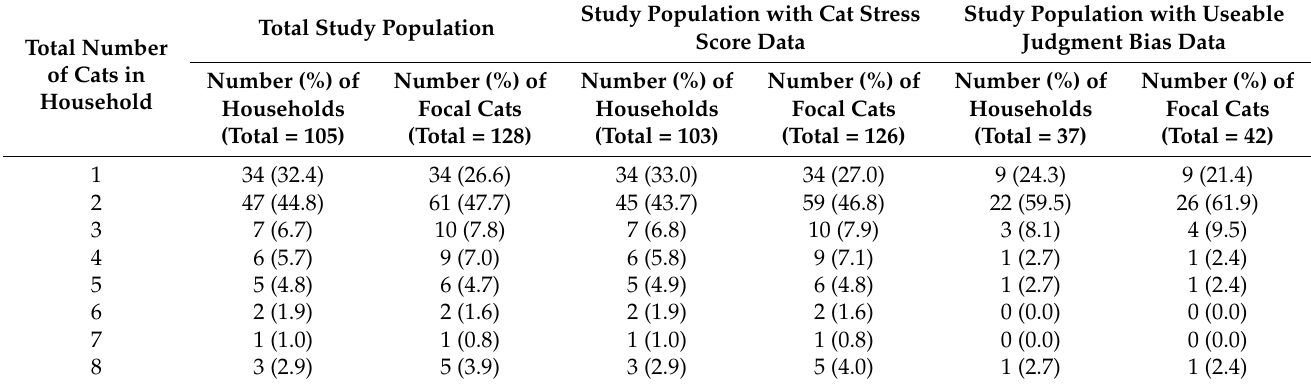
Table 1. The total study population, those with a useable cat stress score and judgment bias